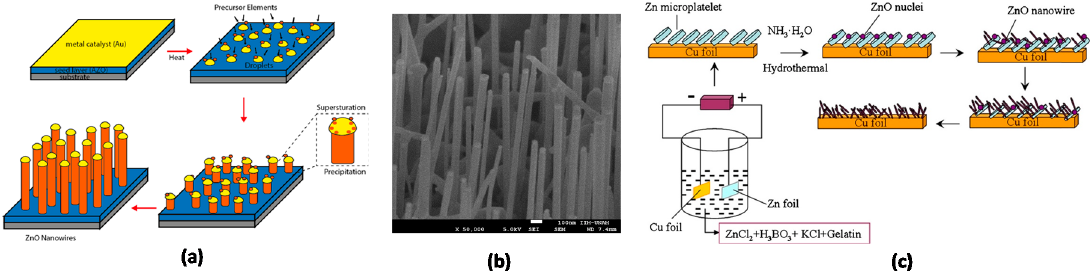
Figure 2. ( a ) Basic principle of the vapor-liquid-solid (VLS) growth mechanism of ZnO NWs using gold as a metal catalyst. ( b ) 45 ◦ side-view SEM image of hexagonally ordered ZnO nanorod grown by VLS method on patterned Au-covered substrates. ( c ) Schematic representation of the growth of nanowires by the hydrothermal technique [60]. Copyright 2015 Elsevier.